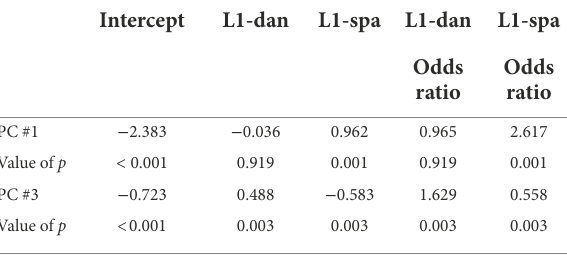
TABLE 7 Use of spatial particle types and tokens by the three participant